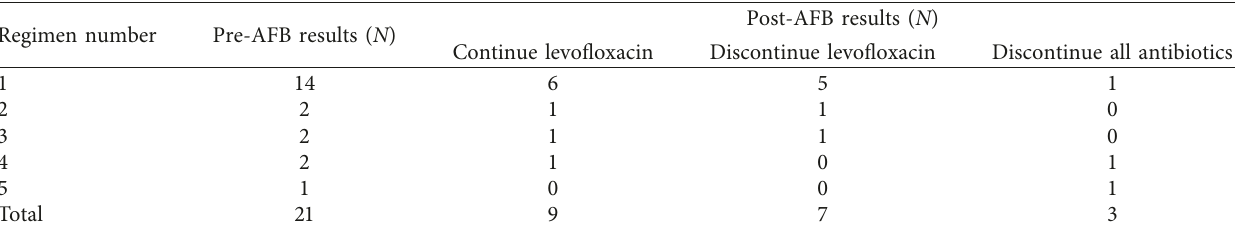
Table 3: The use of levofloxacin that were prescribed after the AFB results.